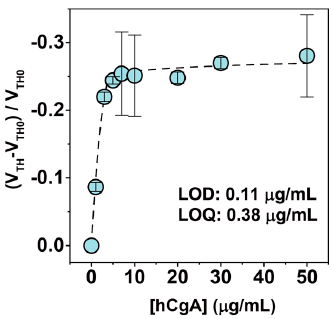
Figure 4. Changes in the threshold voltage ( V TH ) of the OFET by the hCgA at various concentrations in Saliveht ® which contains NaCl, KCl, CaCl 2 , MgCl 2 , and K 2 HPO 4 . [Human CgA] = 0–50 µg/mL. Five repetitions were measured for each concentration.